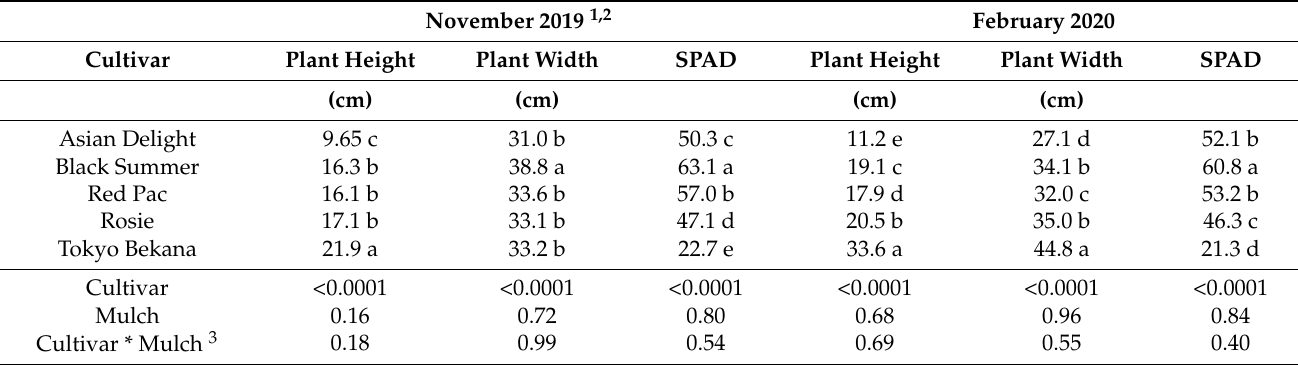
Table 2. Plant height, width, and leaf SPAD in five Asian green cultivars grown with four types of mulches in a high tunnel in Starkville, MS in two